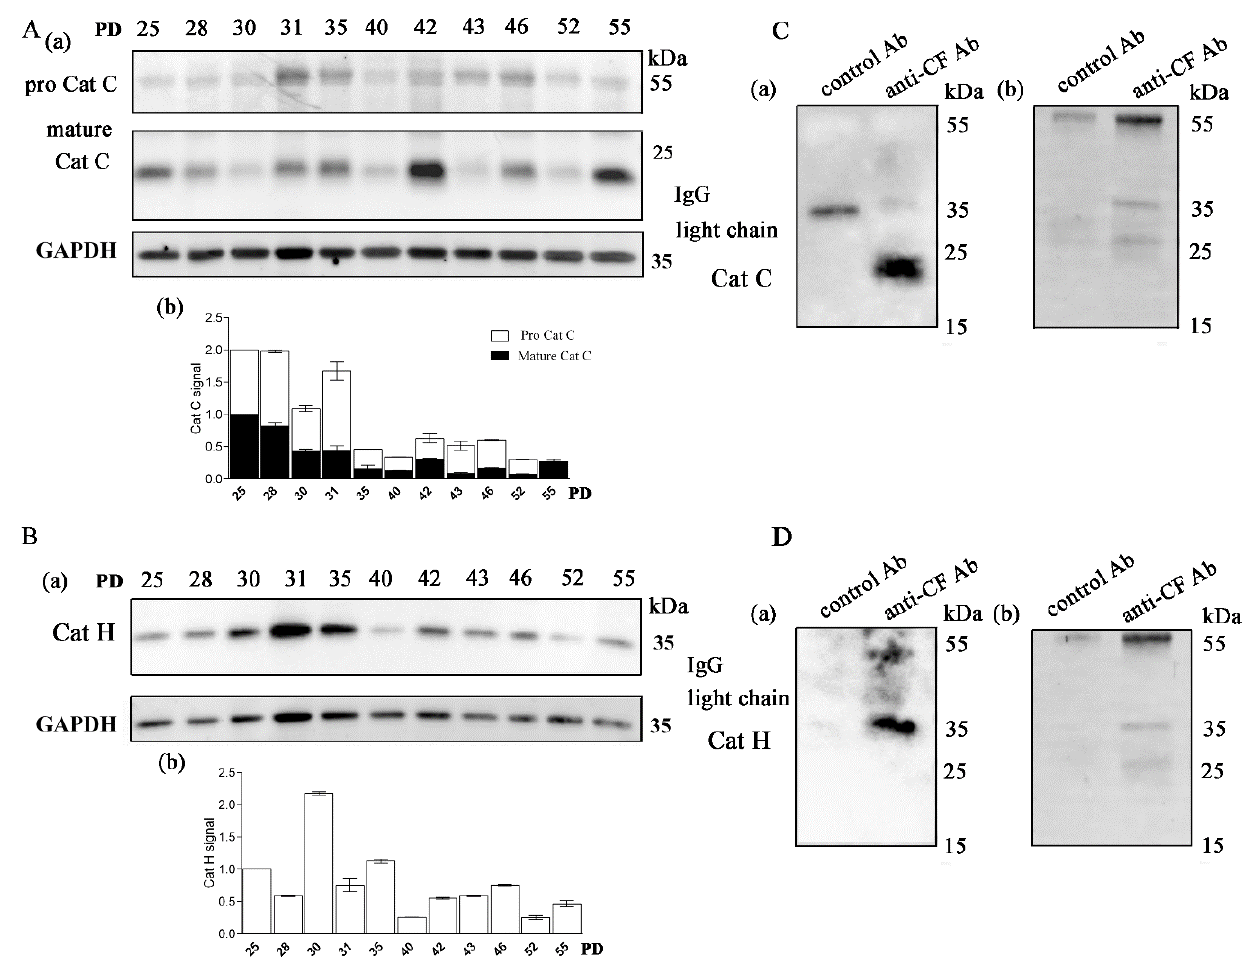
Figure 2. The main targets of cystatin F in long-term cultured CD4+ T cells are cathepsins C and H. ( A ) ( a ) Western blot analysis and cathepsin C (Cat C) immunodetection in cell lysates of CD4+ T-cell clones. ( b ) Quantification of the Western blot experiment shows mature Cat C and pro-Cat C signals. ( B ) ( a ) Western blot analysis and cathepsin H (Cat H) immunodetection in cell lysates of CD4+ T-cell clones. ( b ) Quantification of the Western blot experiment shows mature H signals. ( A , B ) Representative Western blot and quantification for cathepsins C and H. Quantification was performed using whole protein load for normalization and Image Lab Software. The data are represented as mean and standard error of means (SEM). ( C ) ( a ) Western blot analysis and Cat C immunodetection in immunoprecipitates with anti-cystatin F antibodies and negative control antibodies against lectin isolated from Macrolepiota procera for interaction of cystatin F with Cat C. ( b ) Imaging of stain-free activated protein membrane was used to confirm equal protein loading. ( D ) ( a ) Western blot analysis and Cat H immunodetection in immunoprecipitates with anti-cystatin F antibodies and negative control antibodies against lectin isolated from Macrolepiota procera for interaction of cystatin F with Cat H. ( b ) Imaging of stain-free activated protein membrane was used to confirm equal protein